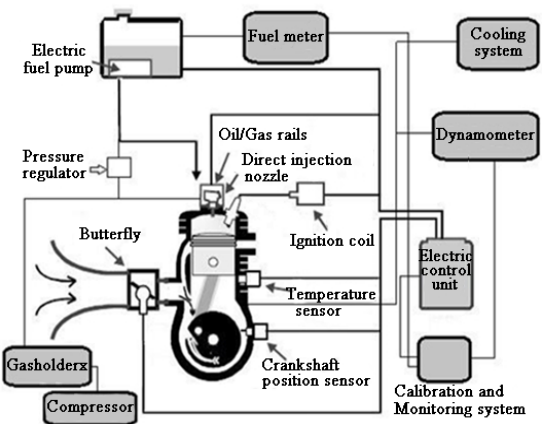
Figure 2. Photographs of the direct injection nozzle and direct injection cylinder head.